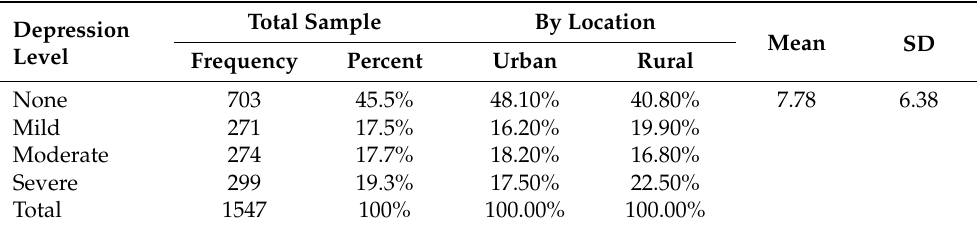
Table 1. Descriptive statistics for Depression Level.